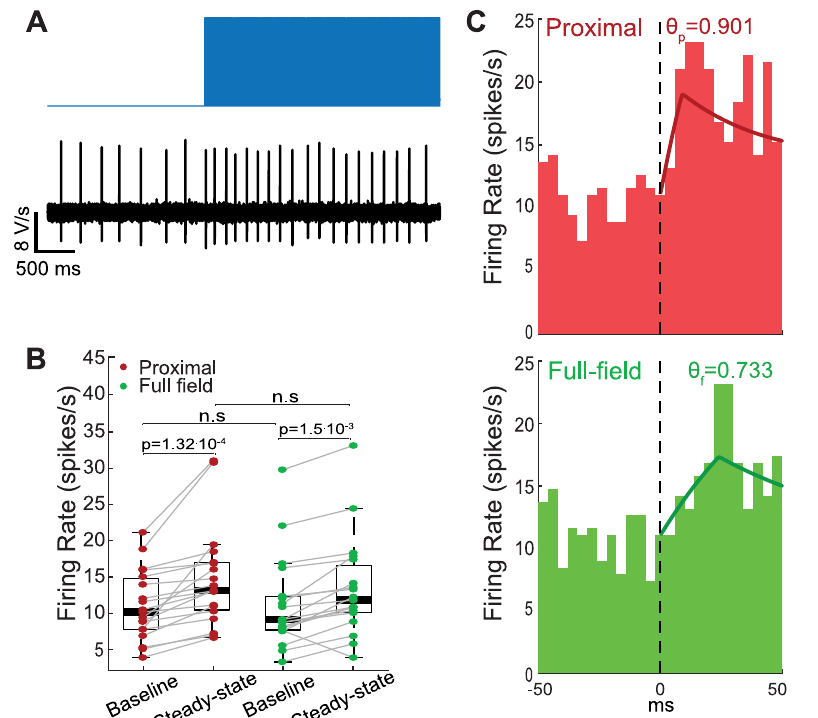
Fig 4. Proximal and full-field barrage stimulations induce distinct peri-stimulus time histograms (PSTHs). A: Example of an increase in the cell’s firing rate in response to barrage stimulation. B: Baseline and steady-state firing rates were similar under the proximal (red) and full-field (green) stimulation conditions (n = 19). Barrage stimulation increased the firing rate significantly (proximal: p = 1.32 � 10 − 4 ; full-field: p = 1.5 � 10 − 3 ; SRT). Central marks indicate the median firing rates and box edges represent 25th and 75th percentiles. n.s—not significant. C: Peristimulus time histograms (n = 19 cells, 25 repetitions per cell) centered around stimulus onset. The peak in population firing rate response to stimulus onset is delayed by approximately 12 ms in the full-field illumination condition (green) compared to the proximal illumination condition (red). Lines represent fitted theoretical curves, corresponding to θ f = 0.733 and θ p =